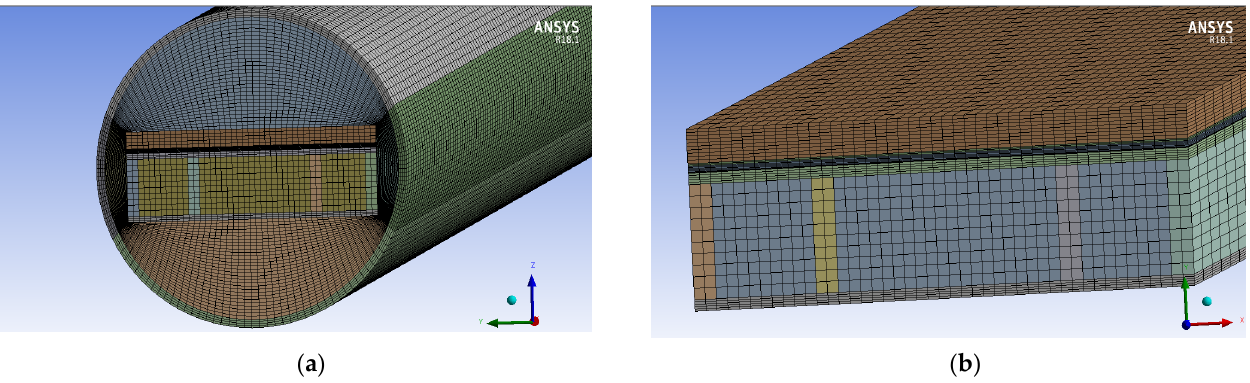
Figure 3. Hexahedral mesh cross view for: ( a ) evacuated PVT and glazed PVT; ( b ) unglazed PVT.